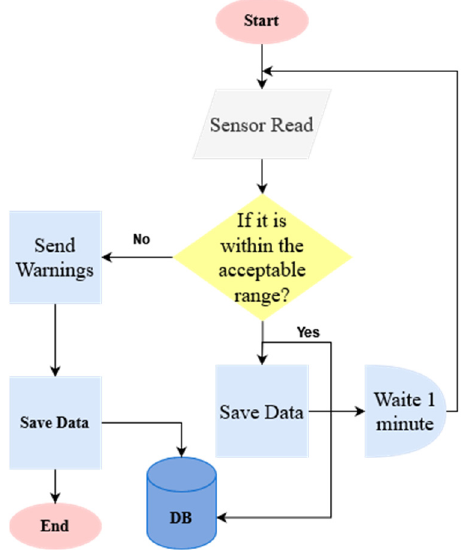
Figure 6. The flowchart of the temperature sensor.